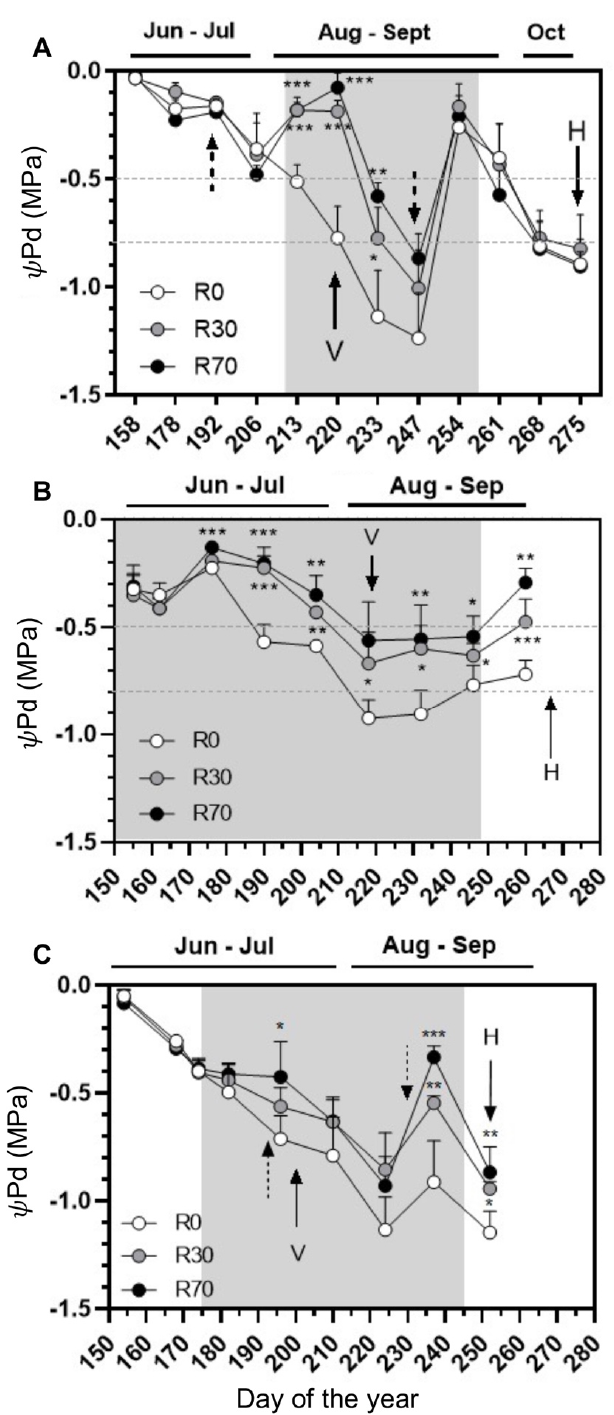
Figure 1. Predawn leaf water potential (ΨPd) of grape cv. ‘Touriga Nacional’ in different irrigation conditions, during ( A ) 2018, ( B ) 2019, and ( C ) 2020 growing seasons. Irrigation conditions: R0 = non-irrigated plants; R30 = deficit irrigation corresponding to 30% of evapotranspiration; R70 = deficit irrigation corresponding to 70% of evapotranspiration. V indicates veraison and H harvest. Dotted arrows indicate dates of precipitation (see supplementary data), shadowed vertical band corresponds to the irrigation interval. The dotted horizontal band represents moderate to severe ( − 0.5 to − 0.8 MPa) water deficit. Results represent mean ± SD of four replicates and the values are marked with asterisks to denote the significance level as compared to the control: * p ≤ 0.05; ** p ≤ 0.01; *** p ≤